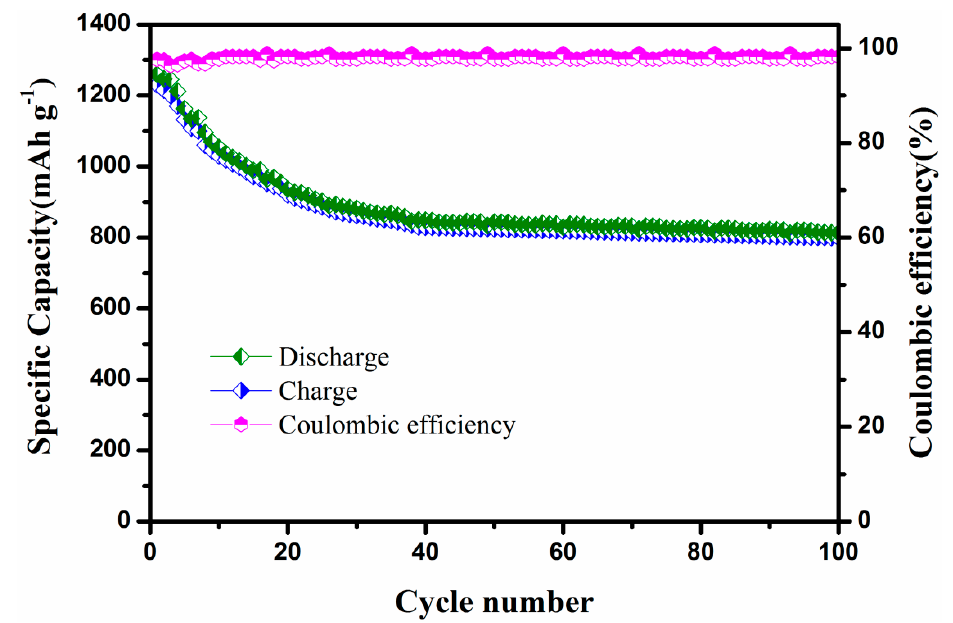
Figure 10. Performance and the responding coulombic efficiency of S/ PTSp/ PAni Composites under discharge rate of 0.1C.